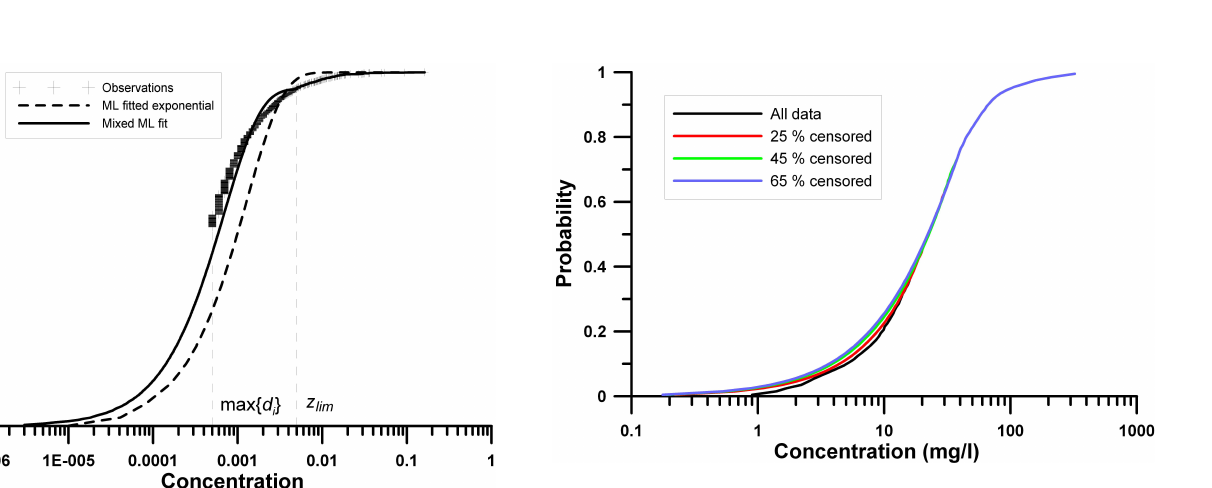
Fig. 1. The empiricel distribution of the observed arsenic concen- trations (crosses) for the values above the highest detection limit and the distributions obtained fitted via maximum likelihood for the whole dataset (dashed line) and with setting z lim to 0.005mgl − 1 (solid line).